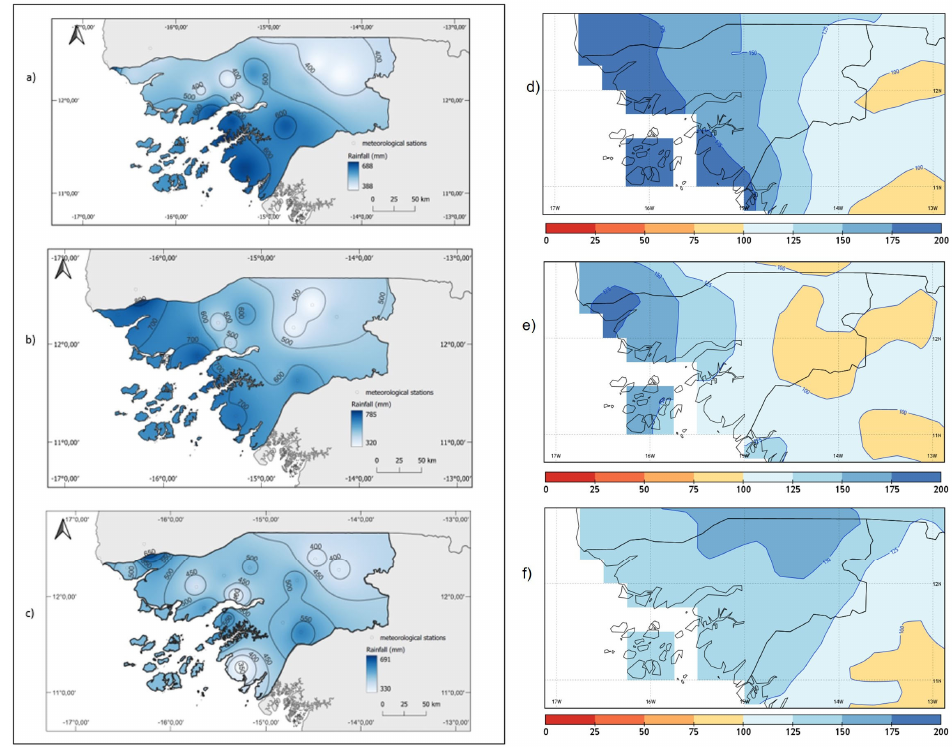
Figure 6. Monthly rainfall (mm) in July ( a ), August ( b ), and September ( c ) 2020, in Guinea ‐ Bissau. Monthly rainfall anomalies (% of 1981–2020 mean) in July ( d ), August ( e ), and September ( f ).